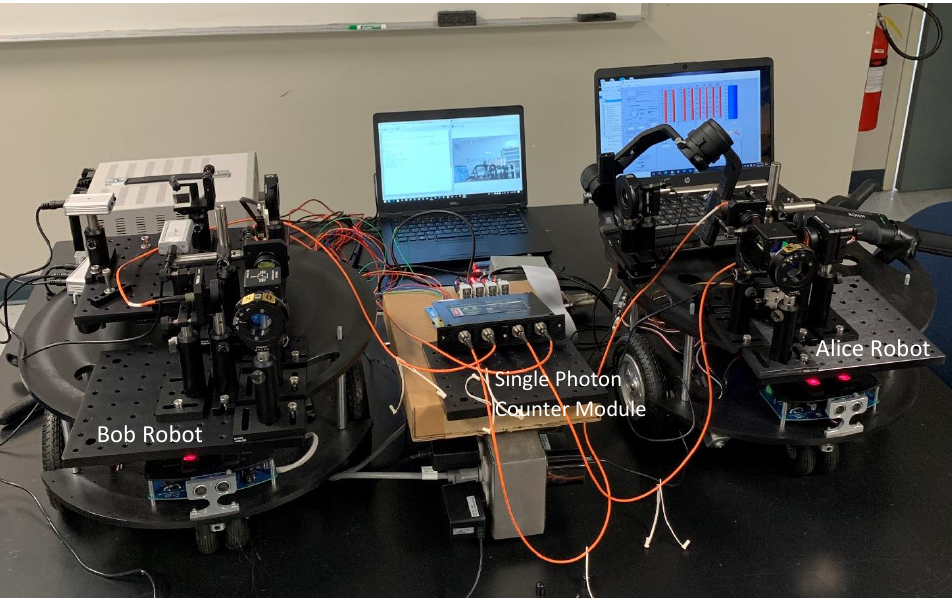
Figure 1. Image of robots prepared for sharing entangled photons. Similar to preliminary theoretical and experimental developments of quantum robotics of Refs.